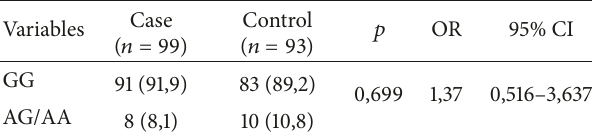
Table 4: Association of thrombomodulin gene polymorphism − 33G > A with acute myocardial